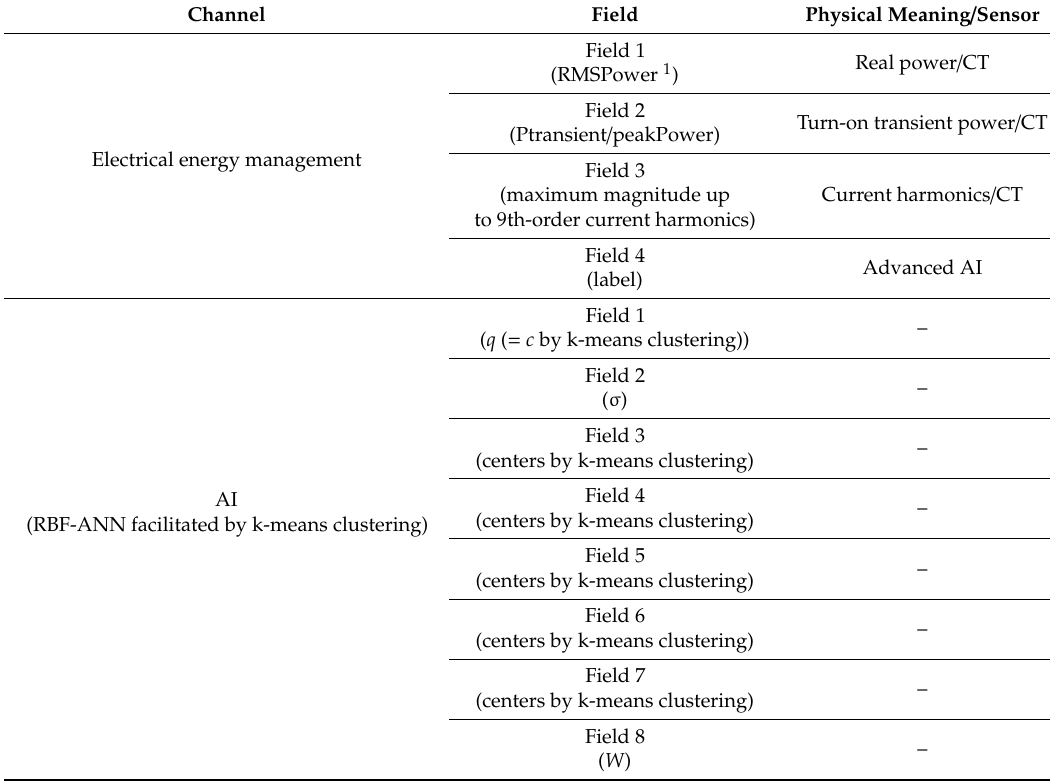
Table 3. Fields of two ThingSpeak ™ channels configured over fog-cloud analytics for load identification in DSM in this study.